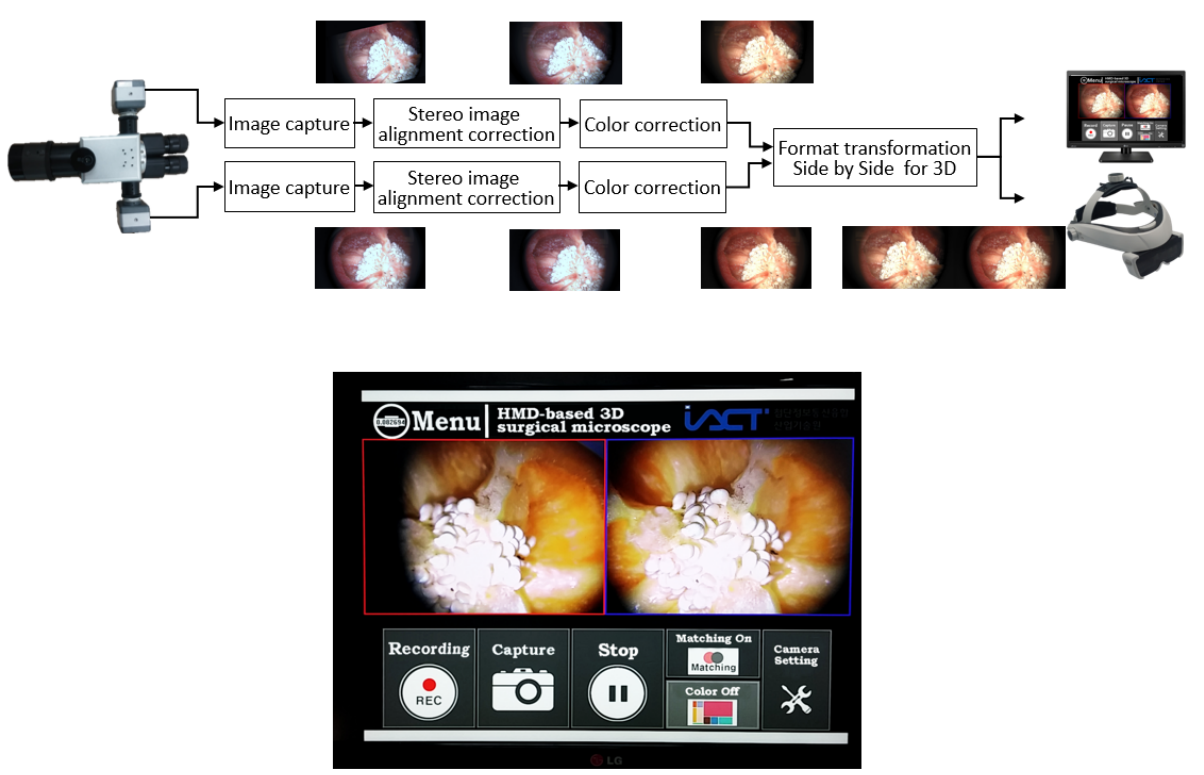
Figure 4. Top: image processing flow; bottom: system control and image processing